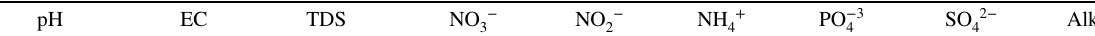
Table 3 Correlation of water quality parameters (Pearson coefficient)